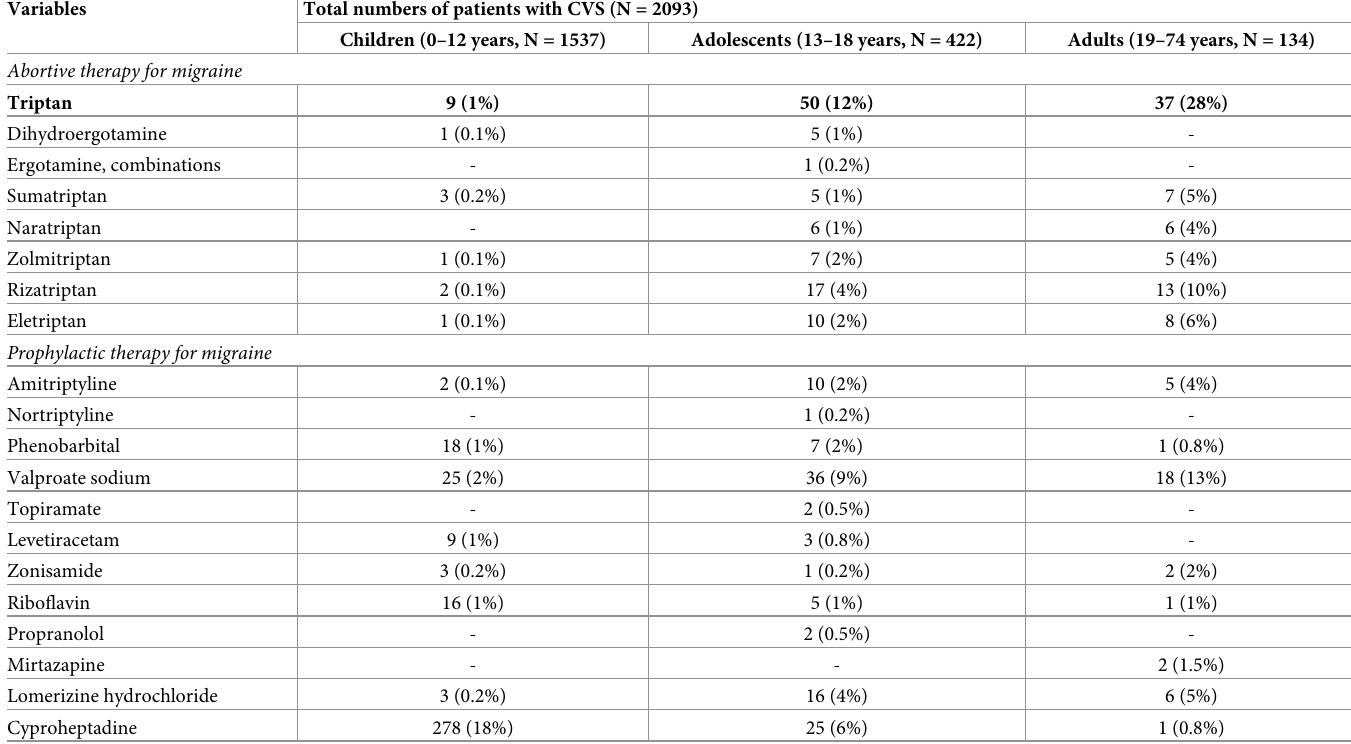
Table 5. Use of migraine-related treatment among identified CVS cases.